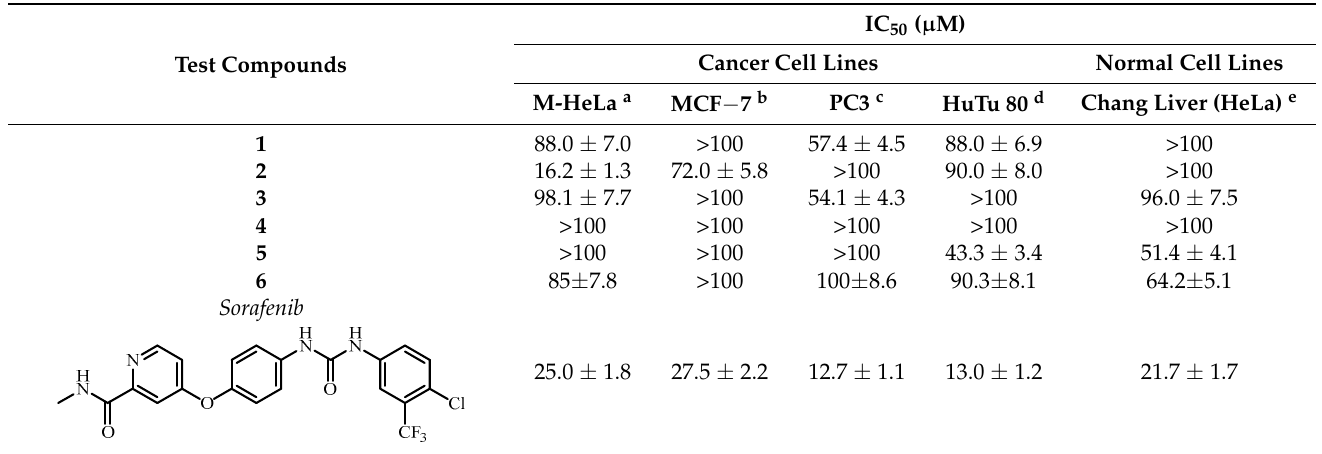
Table 1. Cytotoxic effects (IC 50 , µ M) of tested compounds 1 – 6